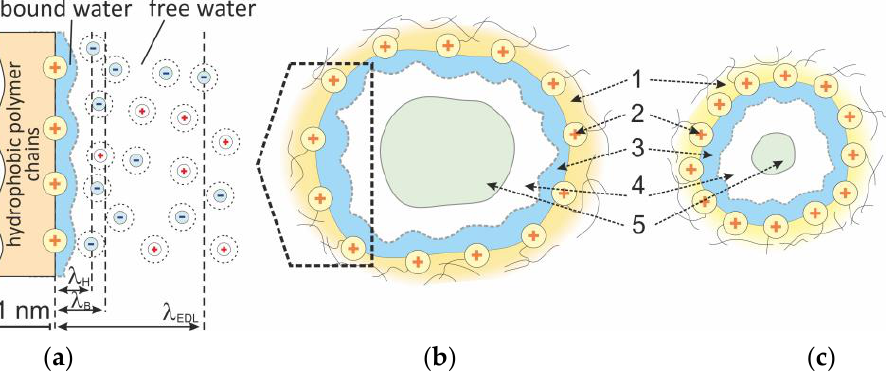
Figure 3. The schematic representation of micro- or mesopore structure showing the cases of a low ( c ) and a high ( b ) degree of swelling. The numbers denote hydrophobic polymer chains (1), fixed ions (2), bound water (3), free water (4) and electroneutral solution (5). In figure ( a ), λ H is the Helmholtz length, λ B is the Bjerrum length and λ EDL is the length of the electric double layer. Since macropores contain almost no bound water and do not contribute to the mem- brane osmotic pressure, their volume is assumed to vary proportionally to the volume of the membrane matrix, i.e.,